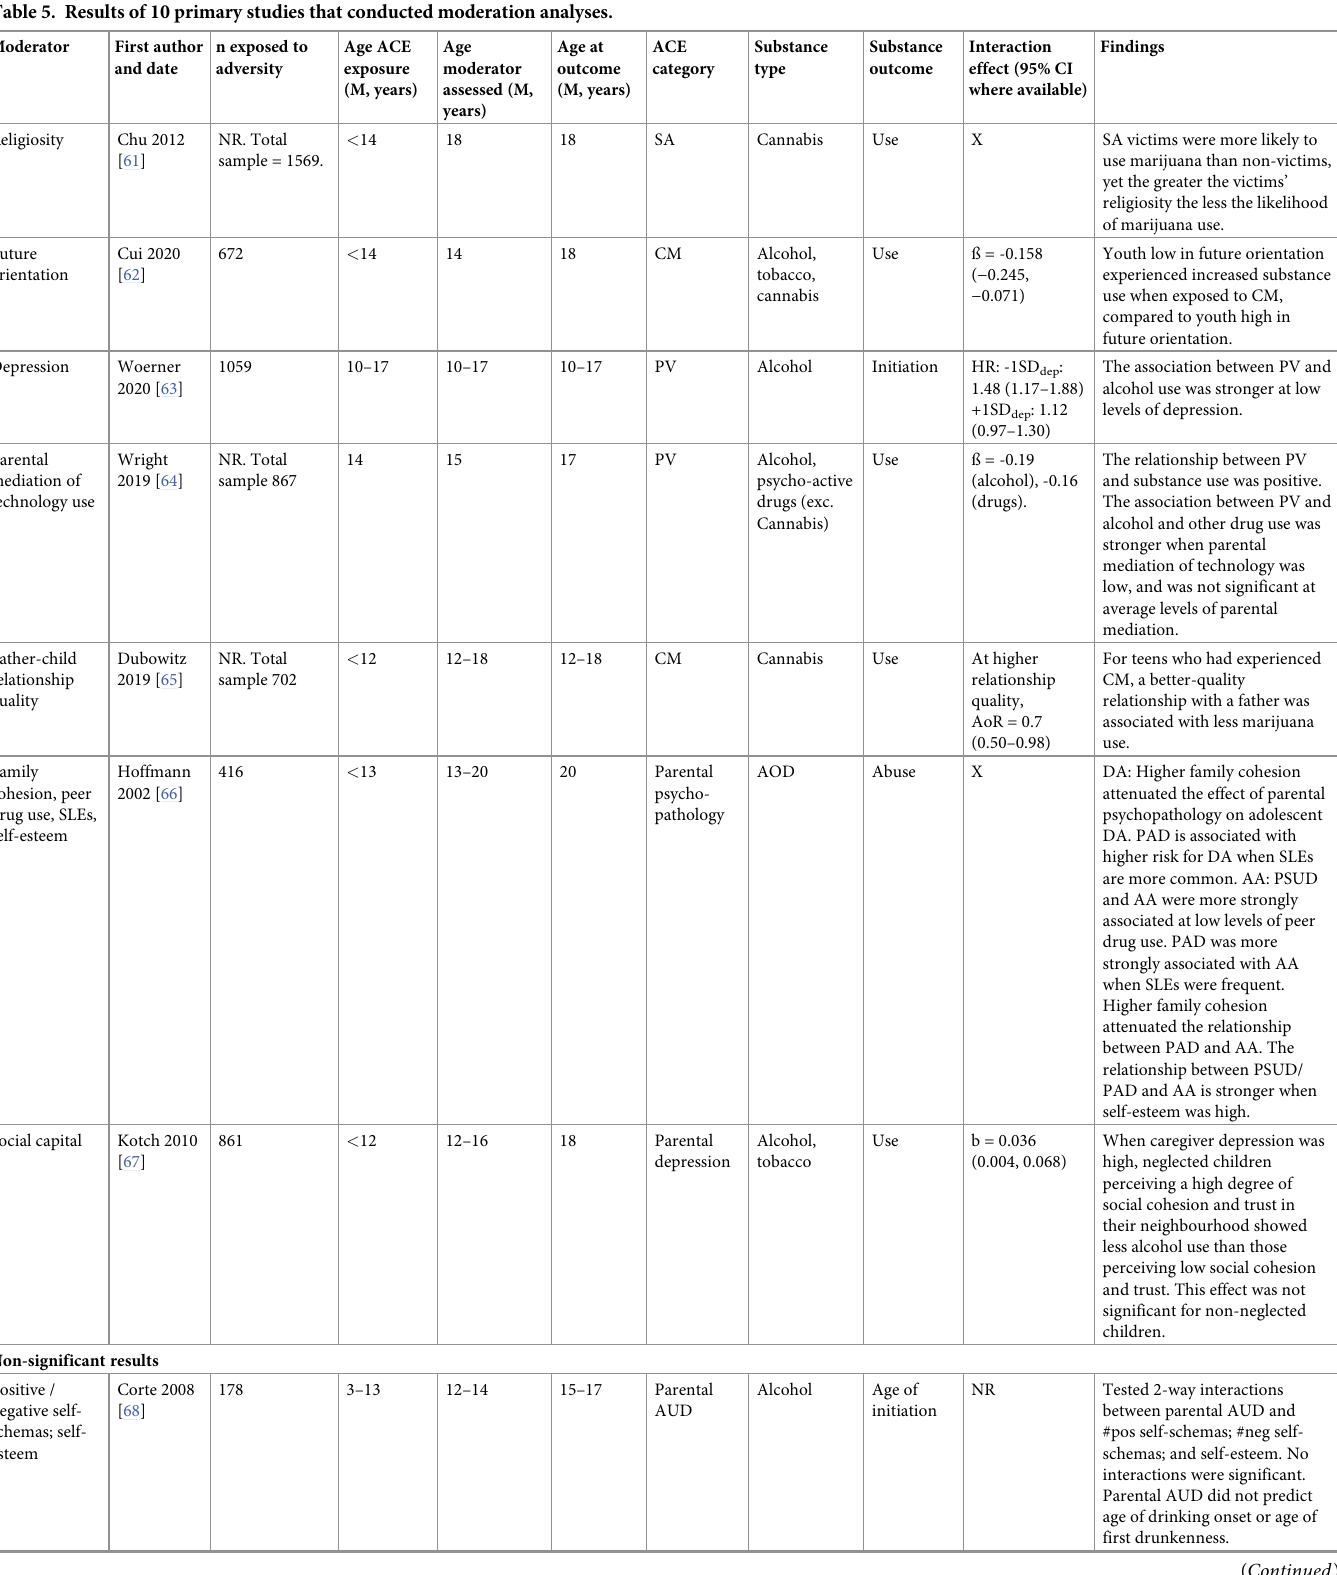
Table 5. Results of 10 primary studies that conducted moderation